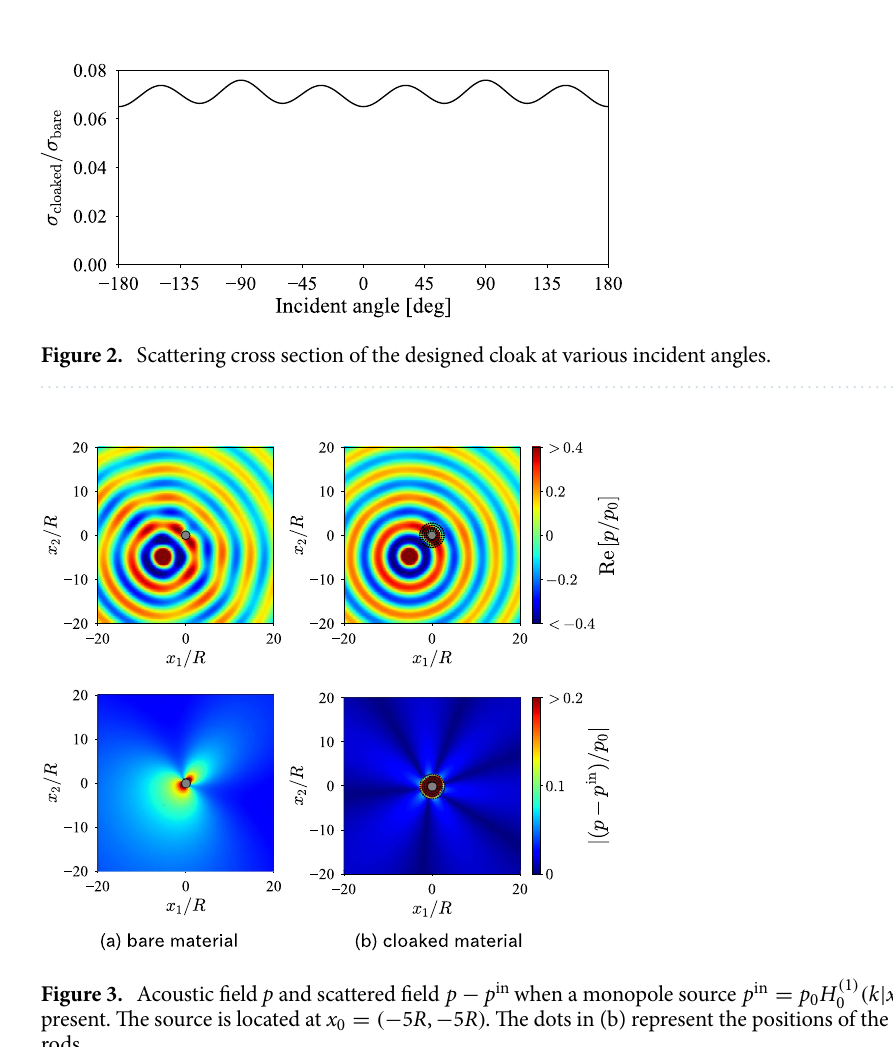
Figure 3. Acoustic field p and scattered field p present. The source is located at x 0